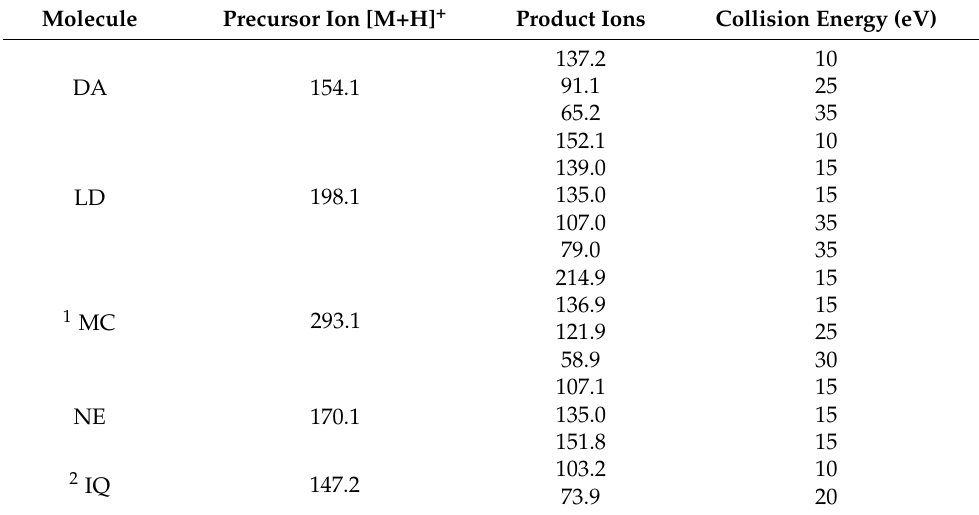
Table 1. Results of LC-MS/MS analysis with MRM parameters in positive-ion mode.